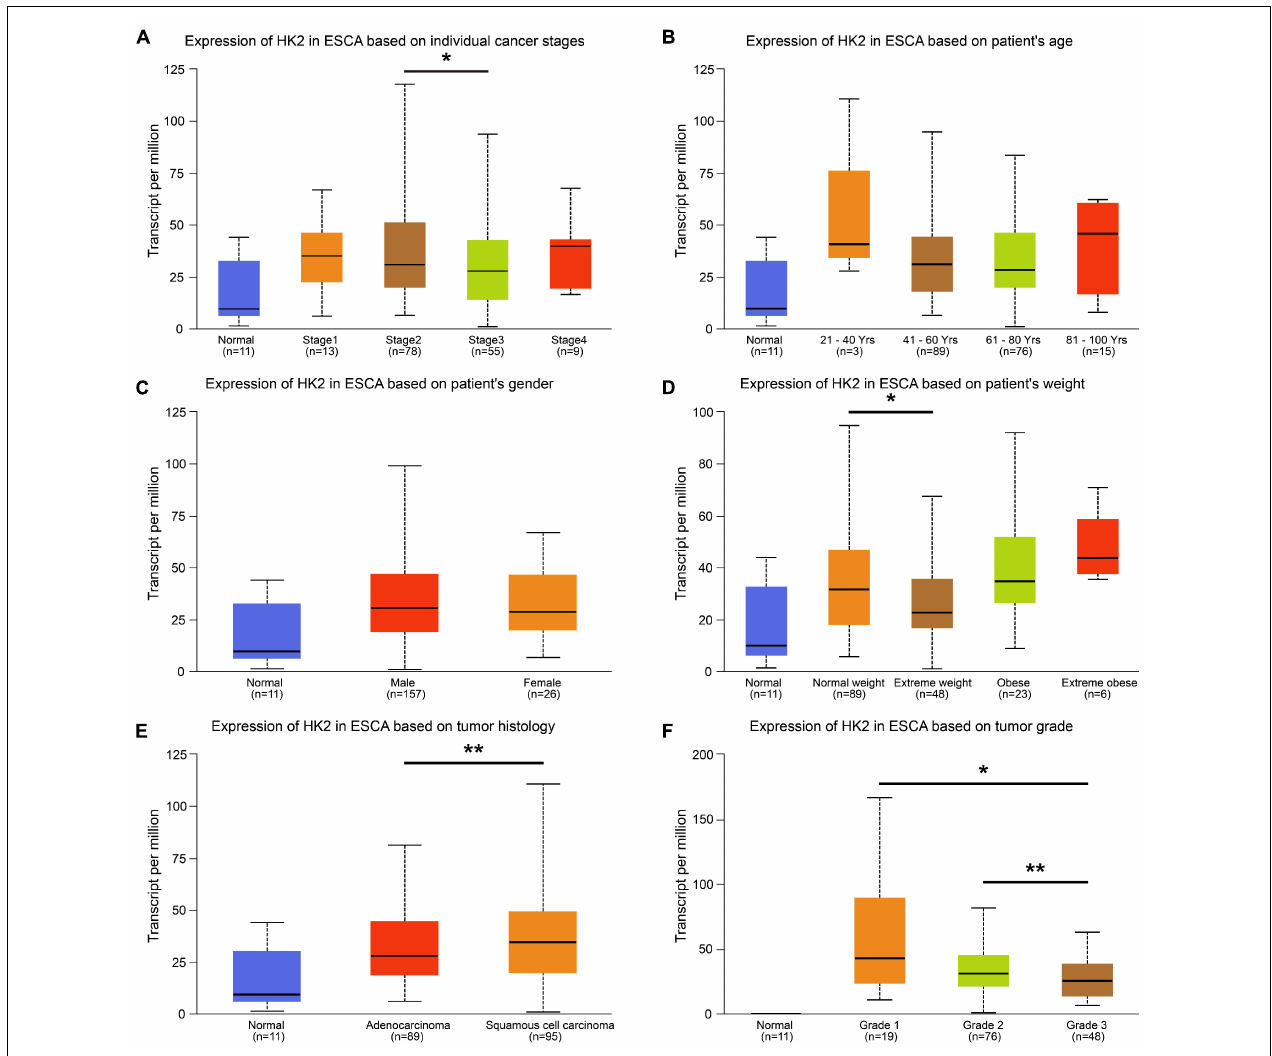
FIGURE 2 | Relationship between HK2 mRNA expression and clinicopathological parameters in esophageal carcinoma (ESCA) patients. The block diagram using the UALCAN network tool shows the correlation between hK2 mRNA expression level and clinicopathological features, including (A) individual cancer stages, (B) patient age, (C) patient gender, (D) patient weight, (E) tumor histology and (F) tumor grade. * P < 0.05; ** P <